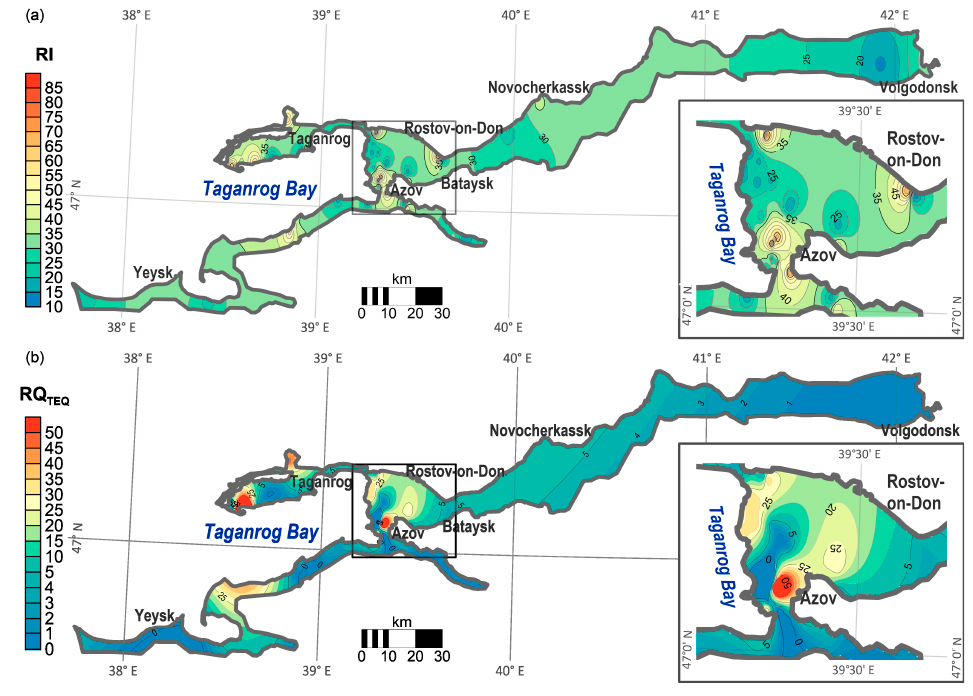
Figure 3. Spatial distribution of cumulative ecological risk indices in topsoils from the Lower Don floodplain and Taganrog Bay coast: ( a ) ecological risk index ( RI ) of PTEs and ( b ) risk quotient ( RQ ) of PAHs and toxic equivalent quotients ( TEQ ).